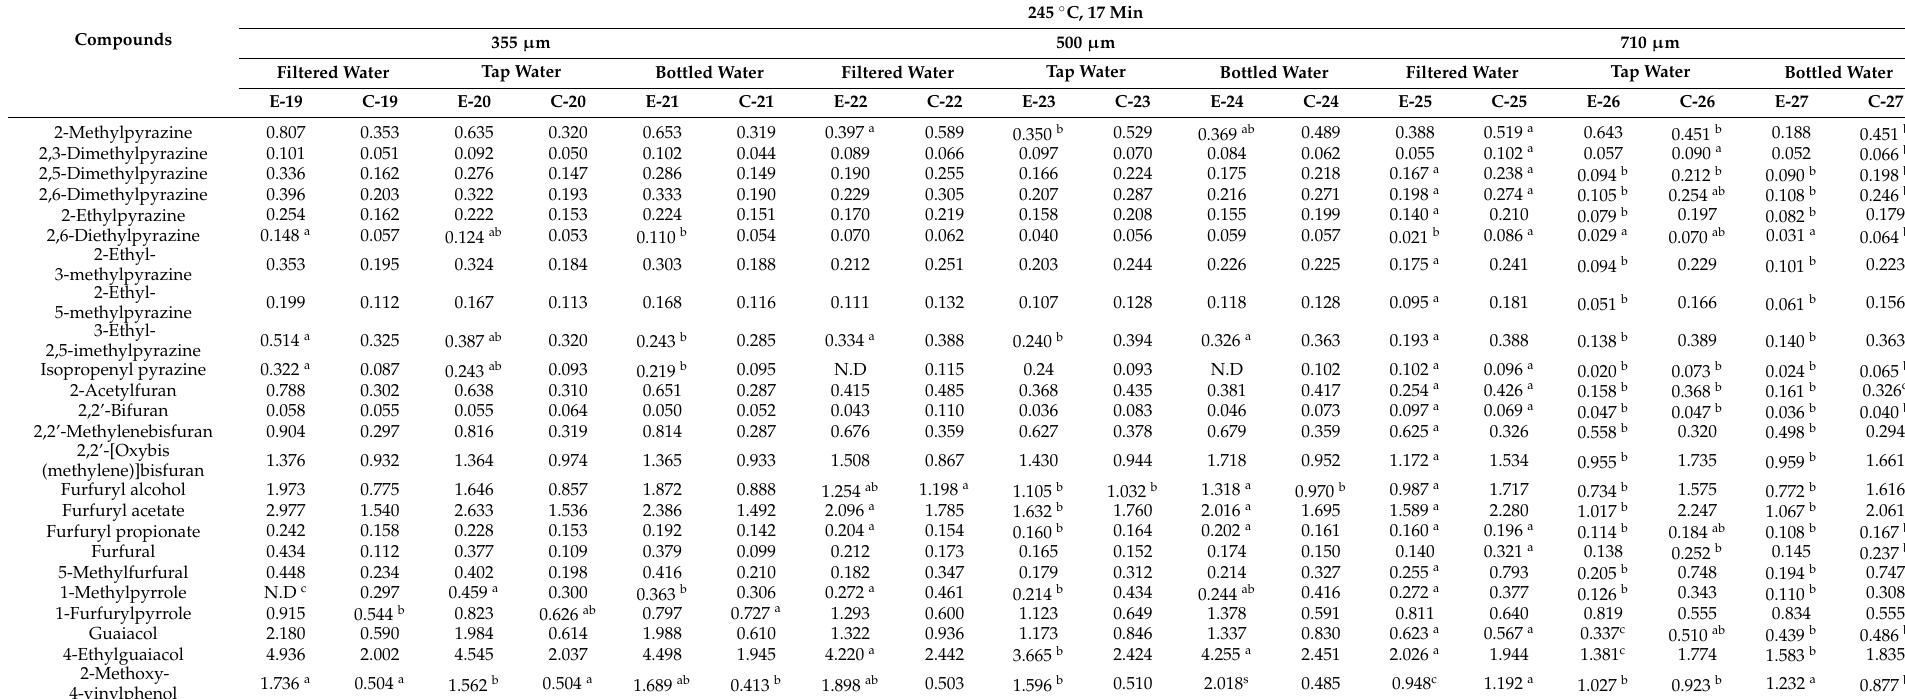
Table 4. Volatile compounds in coffee roasted at 245 ◦ C for 17 min (model E-19 to E-27 for expresso, C-19 to C-27 for cold brew). The sample number was also assigned to the particle Scheme 355. µ m: 19–21; 500 µ m: 22–24; 710 µ m: 25-27). The sample number assigned according to the size of the coffee bean was divided into three equal parts according to the type of water (filtered water: 19, 22, 25; tap water: 20, 23, 26; bottled water: 21, 24,